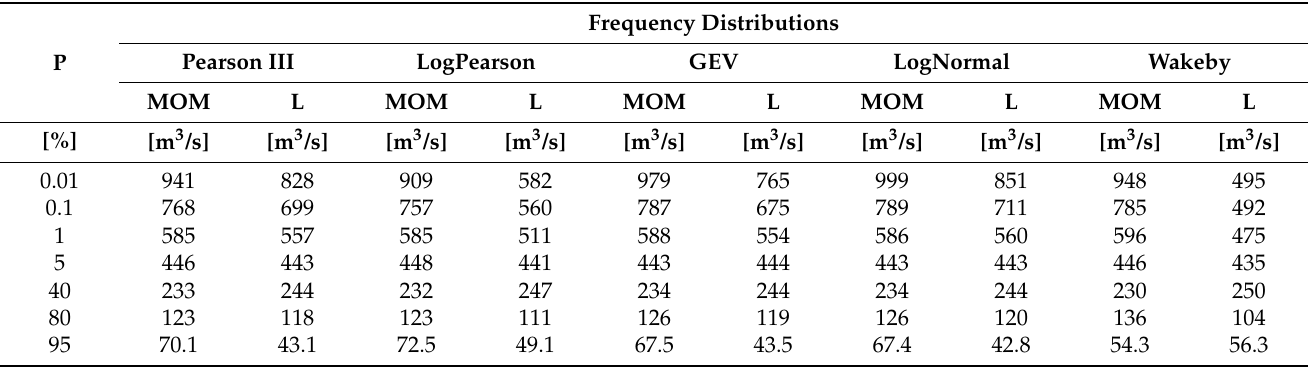
Table 3. Comparison of the estimated values for the usual probability for the Ialomita river.